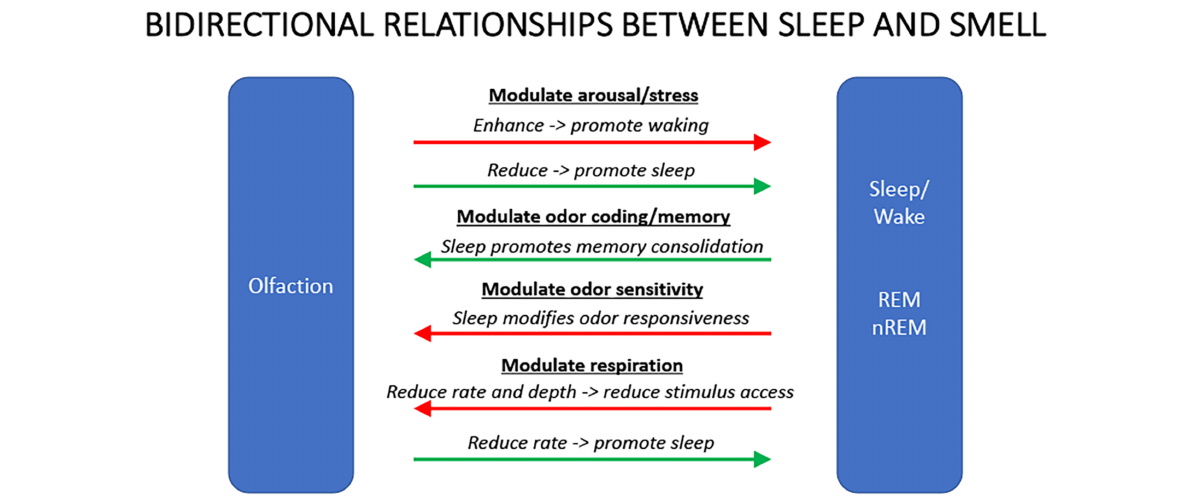
FIGURE3 Summary schematic of some of the major bidirectional interactions between olfaction and sleep. Odors that can enhance arousal or stress will promote waking and/or delay sleep, duration, or quality. Conversely, odors that reduce arousal or stress will promote sleep. Sleep, in turn, can facilitate odor memory consolidation though it can reduce olfactory system sensitivity to ongoing odors. Finally, odors that reduce respiration rate can reduce activity in circuits promoting wakefulness leading to increased probability of sleep. During sleep, respiration rate and depth can impair odor access to sensory neurons contributing to reduce olfactory system